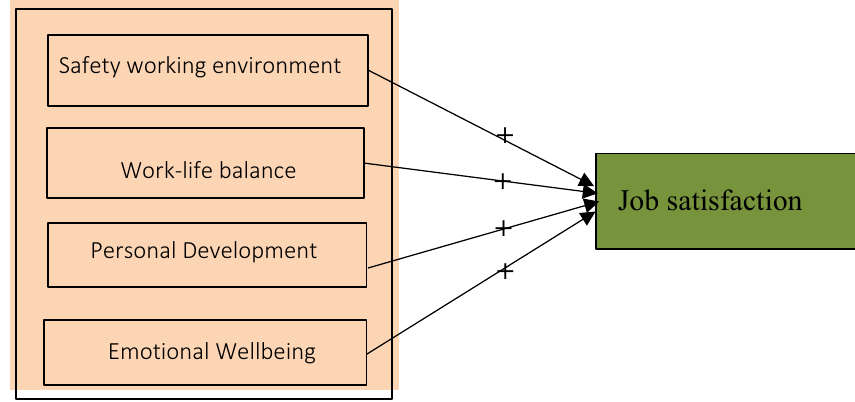
Fig. 2 Conceptual Framework. Source: Authors construct,